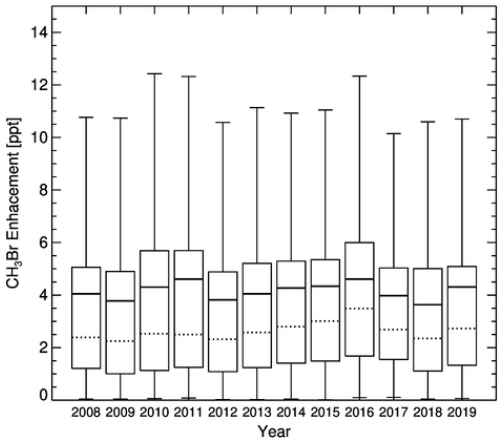
Figure 4. Box–whisker plot of annual enhancements of CH 3 Br at Gosan for 2008–2019. The box encloses the interquartile range (IQR) defined as the 25th–75th percentiles, and whiskers rep- resent maximum (top) and minimum (bottom) enhancements. The solid and dotted lines in the boxes represent the mean and median value of the data,